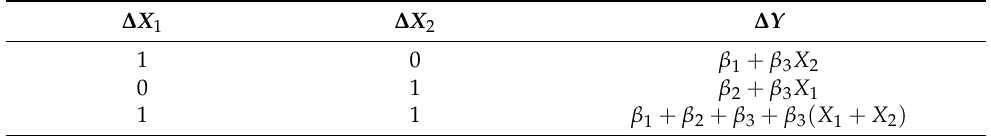
Table 1. Interrelationship of interaction terms.